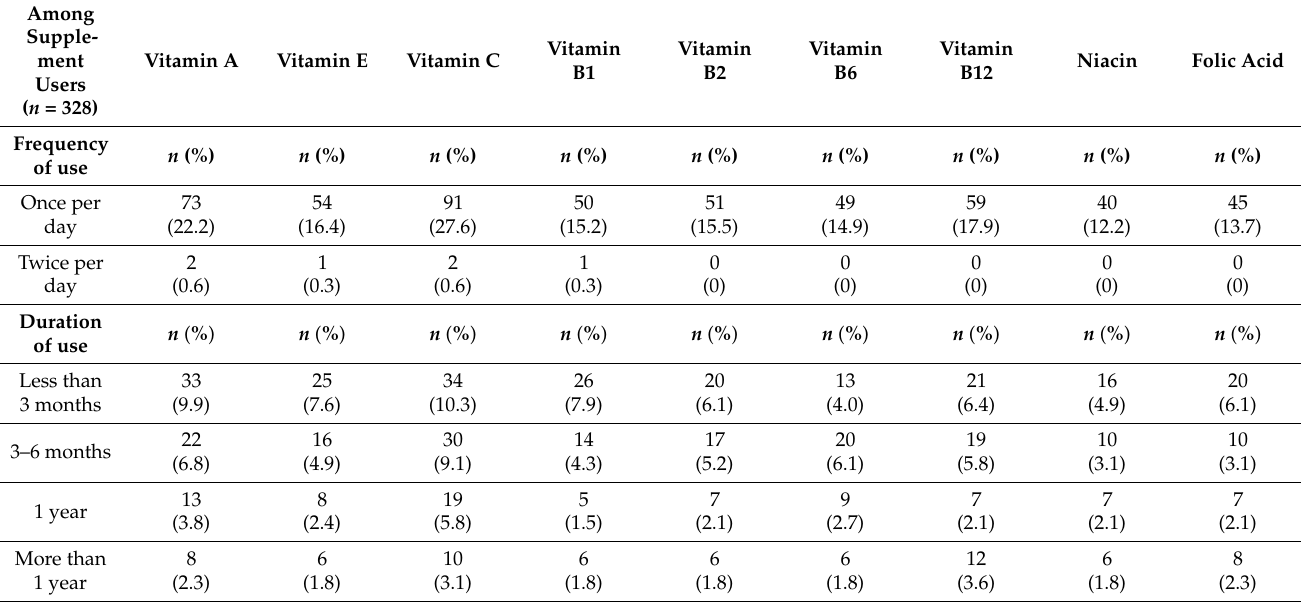
Table 4. The frequency and the duration of use of single vitamin/or mineral and multi-vitamin- mineral supplements among under-5